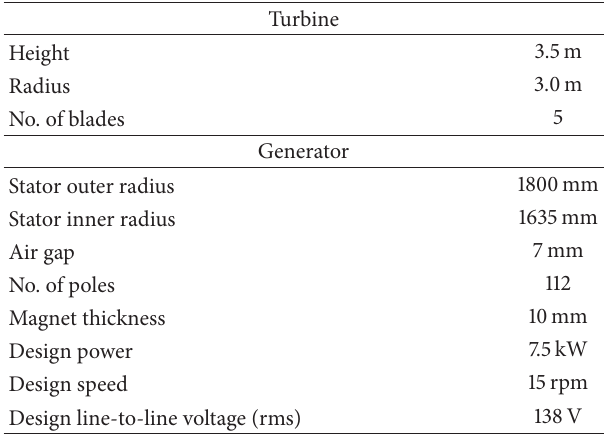
Figure 1: Aerial view of S¨oderfors. The turbine and generator will be installedonthedownstreamsideofthebridge(a),thecontrolstation will be situated about 150m from the turbine (b). A hydropower station is situated upstream from the site (c). Table 1: Design data for S¨oderfors turbine and